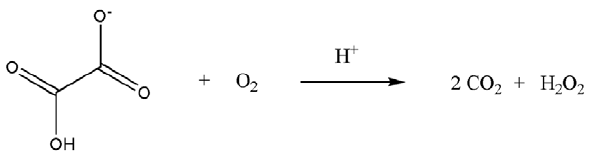
Figure 1. The reaction catalyzed by Ceriporiopsissubvermispora oxalate